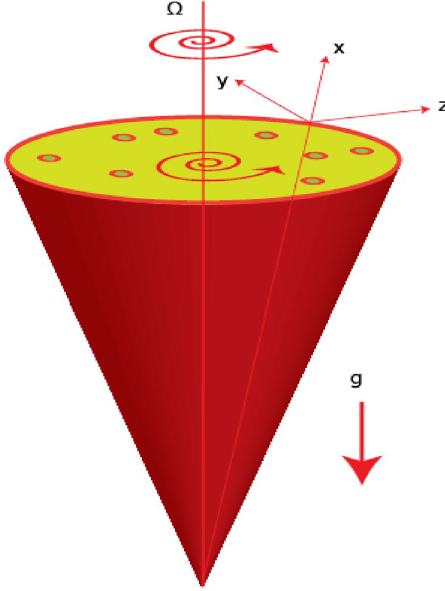
Figure 1. Flow behavior of hybrid nanoparticles.